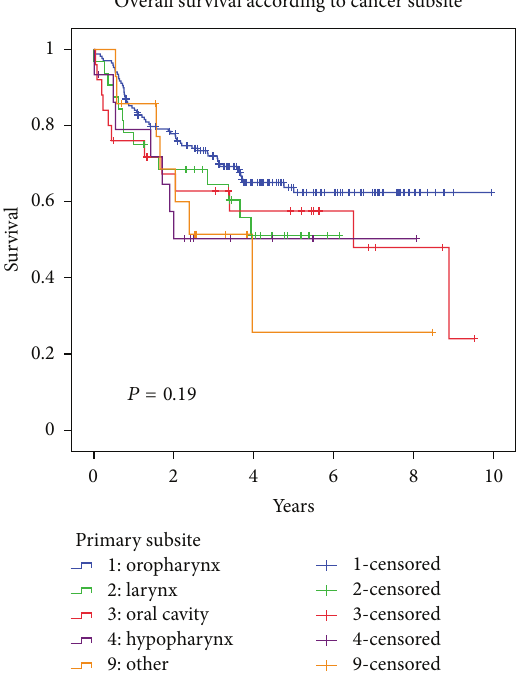
Figure 2: Overall survival according to primary subsite.